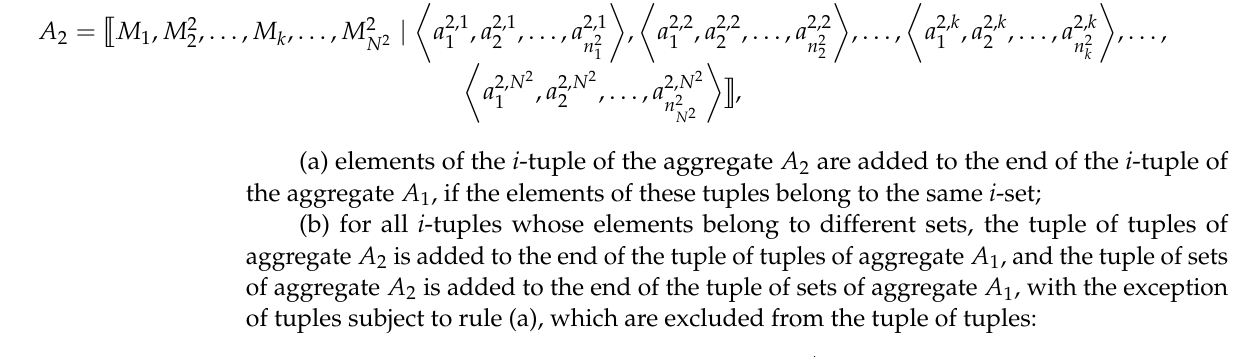
Figure 3. An example of two incompatible aggregates.